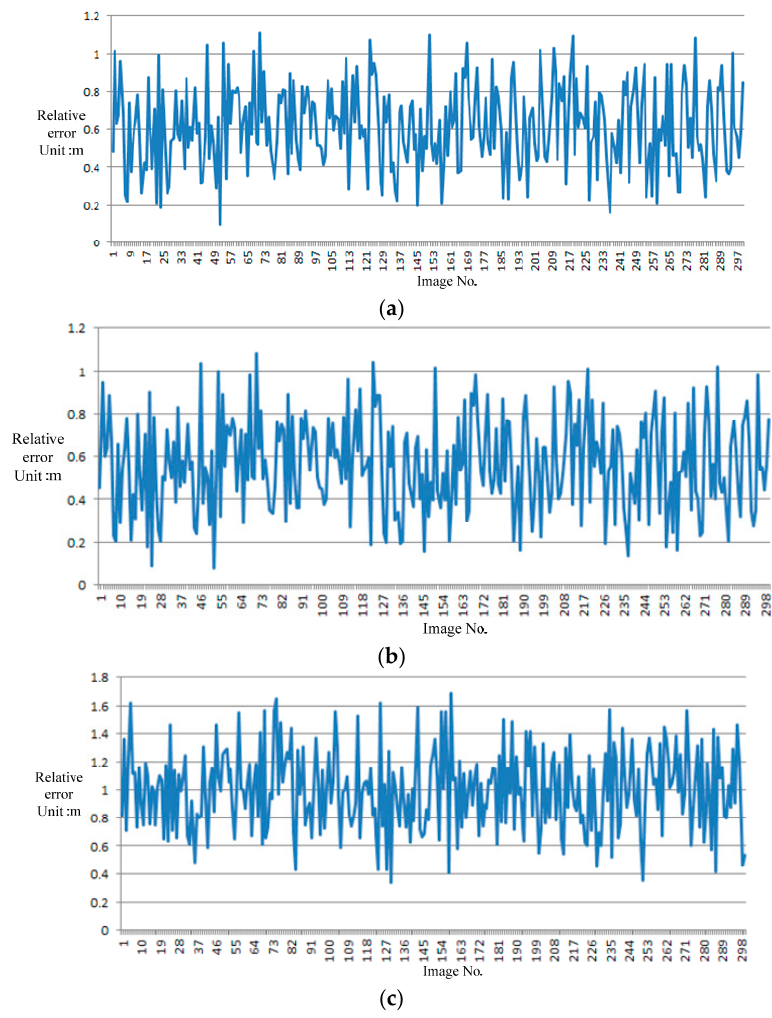
Figure 8. Accuracy of the proposed vision navigation approach: ( a ) x direction; ( b ) y direction; ( c ) H .